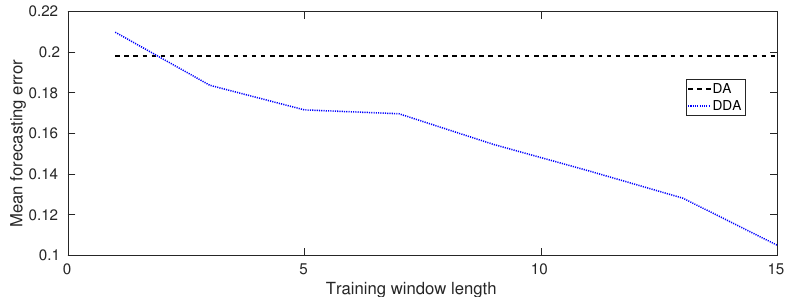
Figure 6. Mean forecasting error-first test case.